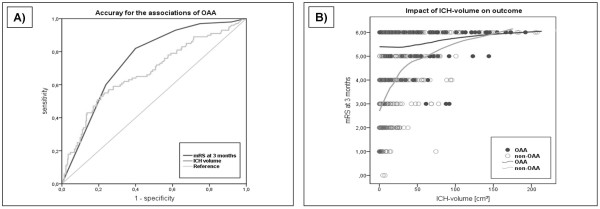
(A) Receiver operating characteristics curve for the association of OAA with ICH volume and outcome. (B) Graphical regression analysis; LOWESS graph (a = 0.25-0.5, tension = 66), evaluating the influence of ICH volume on outcome for OAA- and non-OAA patients. Note, that in non-OAA patients hematoma volume is of greater relevance to outcome (especially for volumes < 30 cm3) than in OAA-patients.